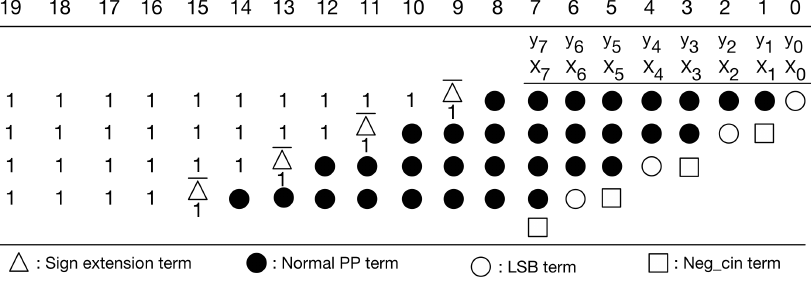
Figure 10. The modified PPM of radix-4 booth encoding with guard